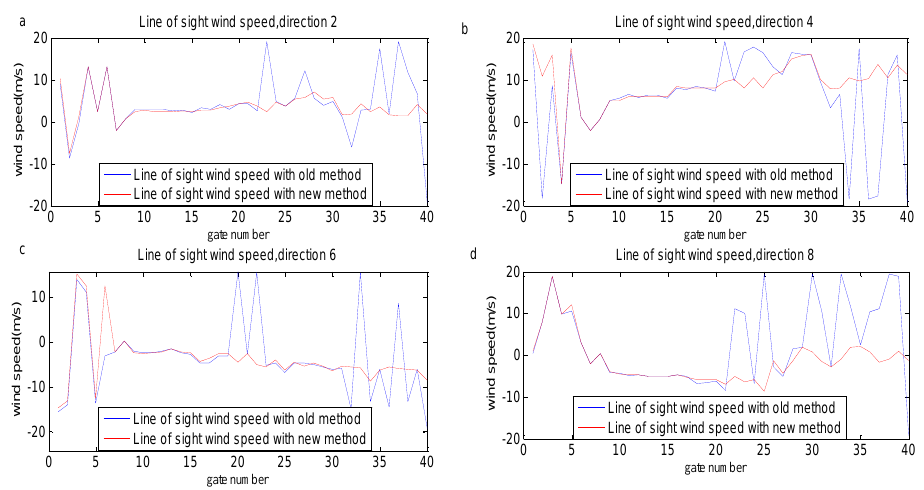
Figure 6. Line of sight wind speed at different directions. Line of sight wind speed in: ( a ) direction 2; ( b ) direction 4; ( c ) direction 6; and ( d ) direction 8.